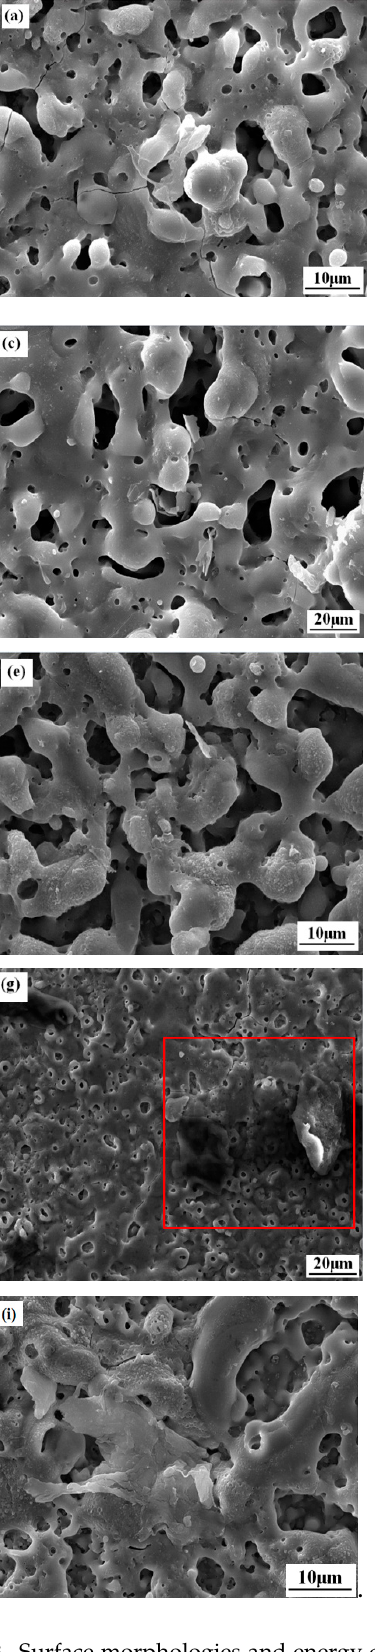
Figure 2. Surface morphologies of the coatings with different concentrations of graphene: ( a , b ) G0, ( c , d ) G1, ( e , f ) G2, ( g , h ) G3, ( i , j ) G4, ( k , l ) G5; ( b , d , f , h , j,l ) the magnification morphologies of the graphs ( a , c , e , g , i , k ).